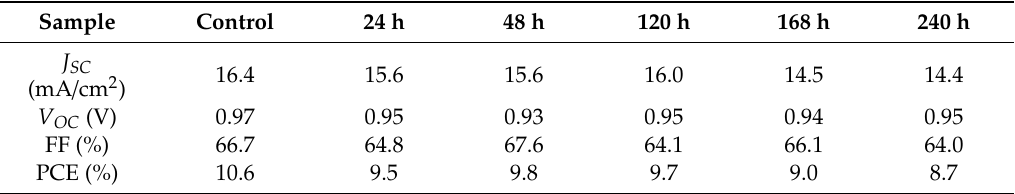
Figure 2. The UV-vis absorbance spectrum for control, 120 h and 240 h degraded perovskite films. Perovskite films were deposited on the PEDOT:PSS coated substrates. Table 1. Photovoltaic parameters of PSCs regarding degradation time.